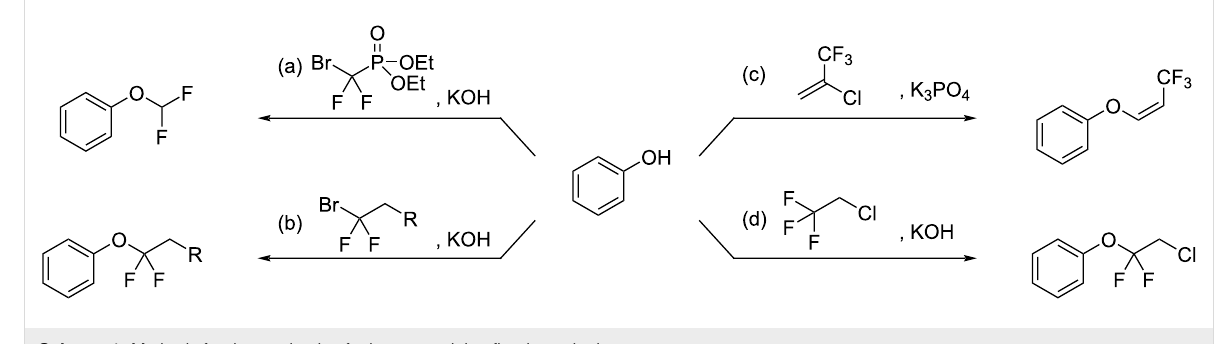
Scheme 1: Methods for the synthesis of ethers containing fluorine substituents.